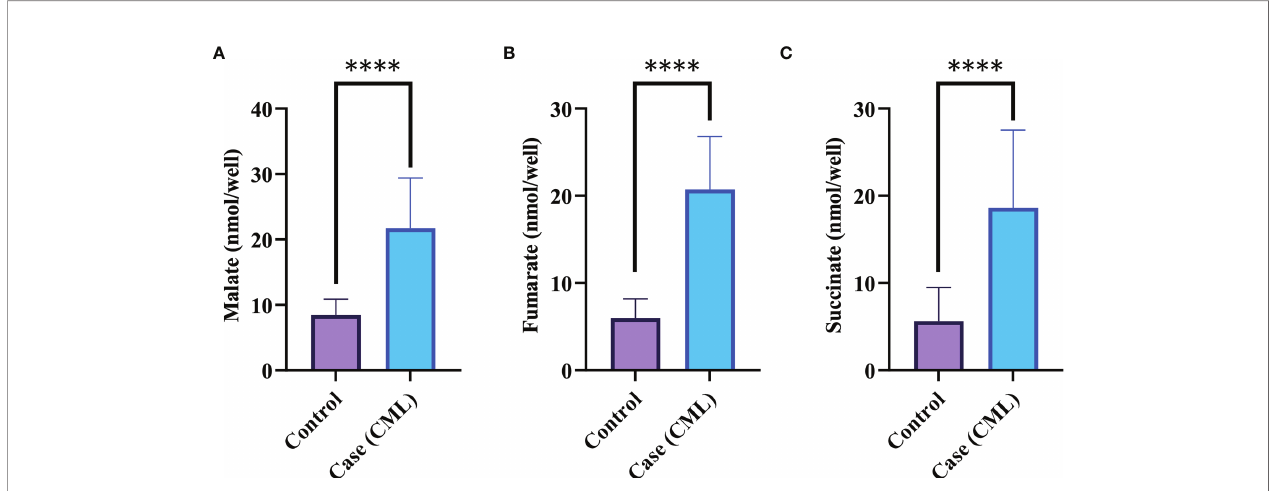
FIGURE 3 | Krebs metabolite in CML progression. (A – C) Krebs cycle oncometabolites in CML were quanti fi ed by colorimetry. Malate, fumarate, and succinate levels were found to be high in CML patients, with fold changes of 1.3609, 1.709, and 1.7231, respectively. All data are mean ± SD, ****p<0.00001, Student ’ s t-test